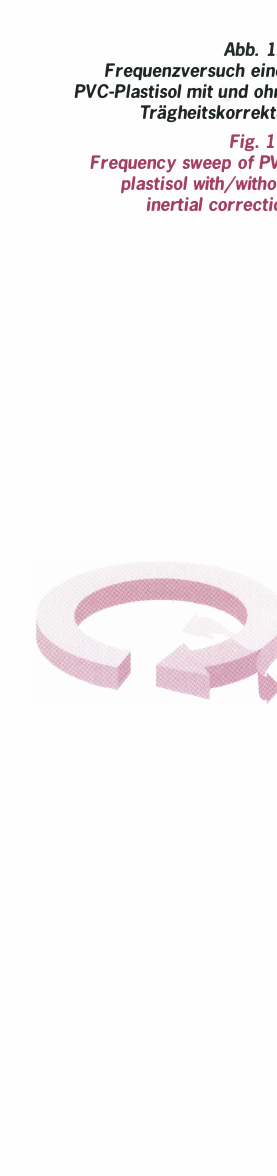
Fig.lO: Frequency sweep of PVC plastisol with/without inertial correction Fig. 11: